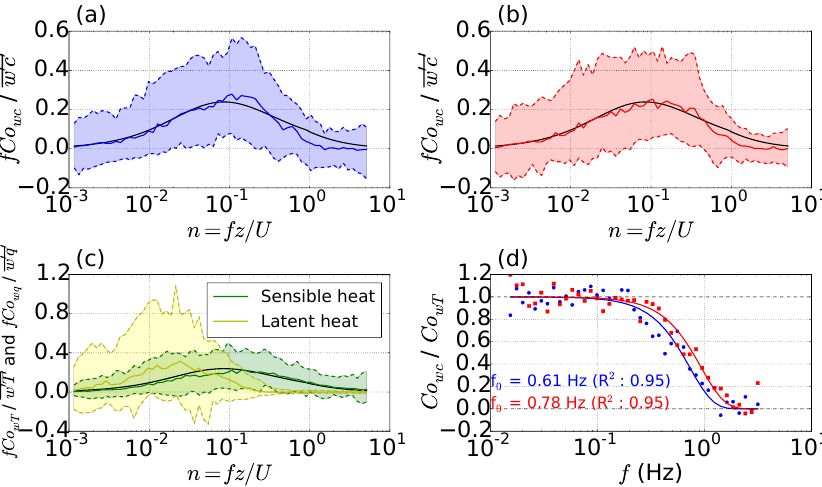
Figure 4. Normalized cospectral densities Co w CO of (a) the test setup and (b) the standard setup, and (c) Co wT (green) and Co wq (yellow). 2 The solid lines represent the median cospectra, and the dashed lines represent the 10th and 90th percentiles. The black line is the model Co wT (Horst, 1997). (d) Ratios of cospectral densities (dots) and the fitted exponential transfer functions (solid lines), where red indicates the standard setup, and blue indicates the test